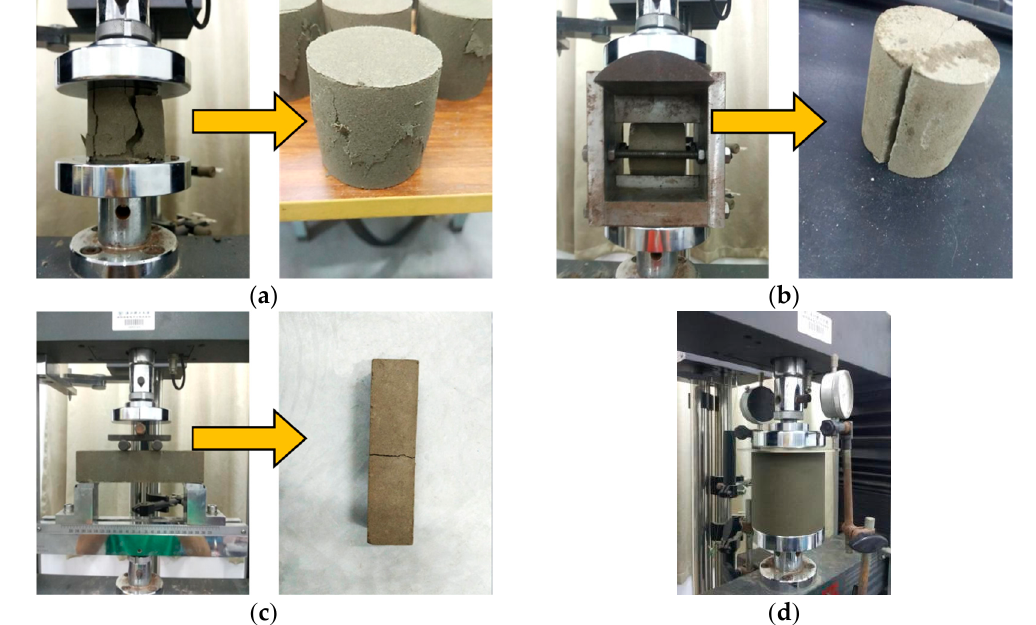
Figure 2. Test set-up and failure details of the specimens: ( a ) unconfined compression strength, ( b ) tensile strength, ( c ) flexural strength, and ( d ) compressive resilient modulus tests.